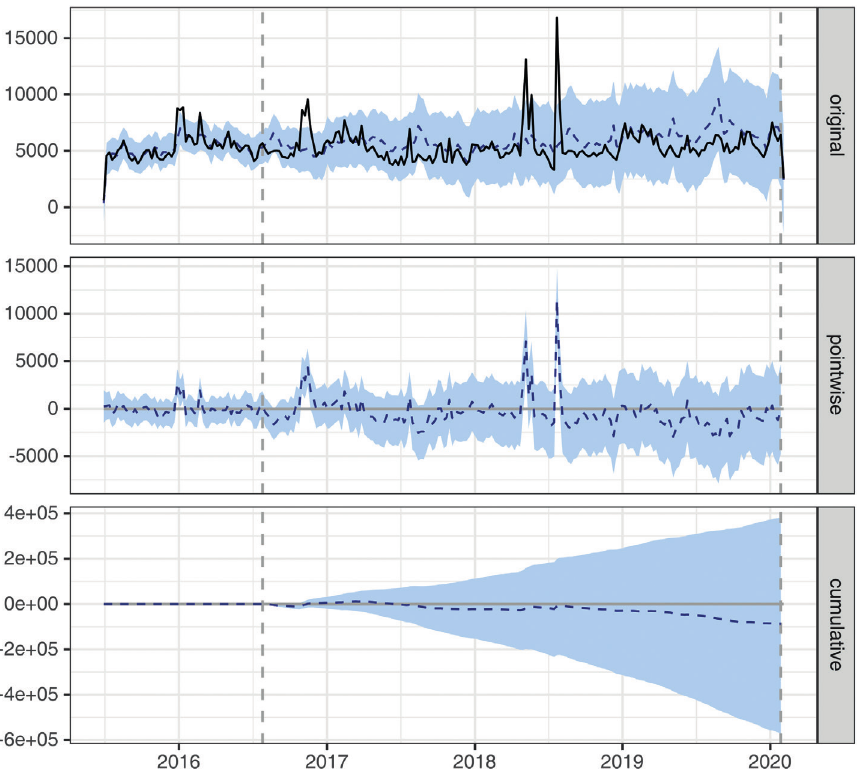
Figure 2. Causal impact of the first Union list (vertical dashed line) on visits to Wikipedia pages about invasive alien mammals that were included in the list. Upper plot: visits to pages of invasive mammals in the list (solid line) versus the counterfactual, obtained from visits to pages of native mammals (dashed line and highlighted area). Middle plot: estimated causal effect, expressed as the difference between treated and control time series. The causal effect was significant if its 95% credibility interval did not include zero. Lower plot: cumulative causal effect in time, significant only when the 95% credibility interval did not include